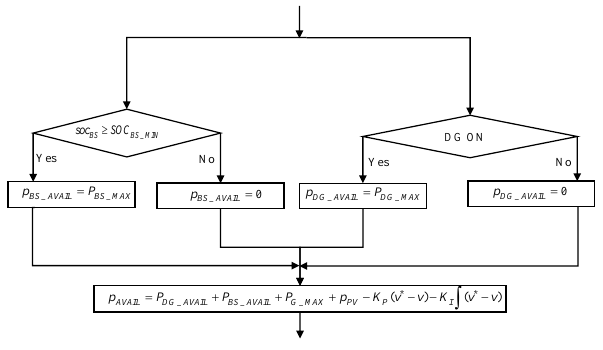
Figure 2. Flowchart of operational power control and management algorithm.